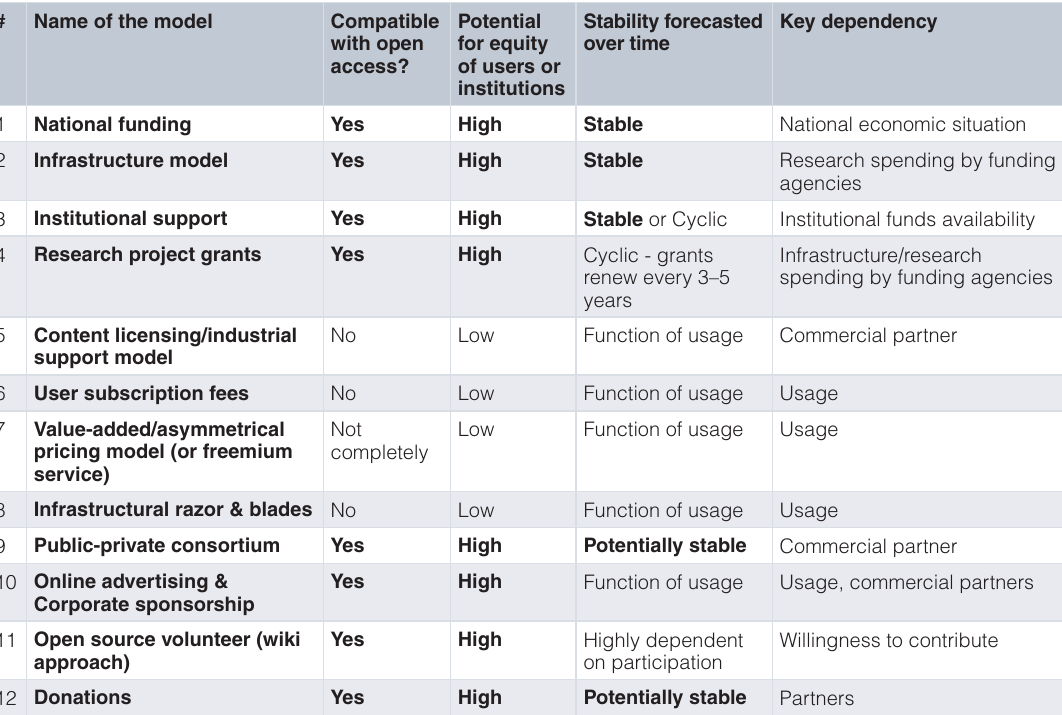
Table 1. Comparison of the 12 models in function of open access, equity, stability and key dependency. The aspects that favour open access, equity of users and stability over time are highlighted in bold. # Name of the